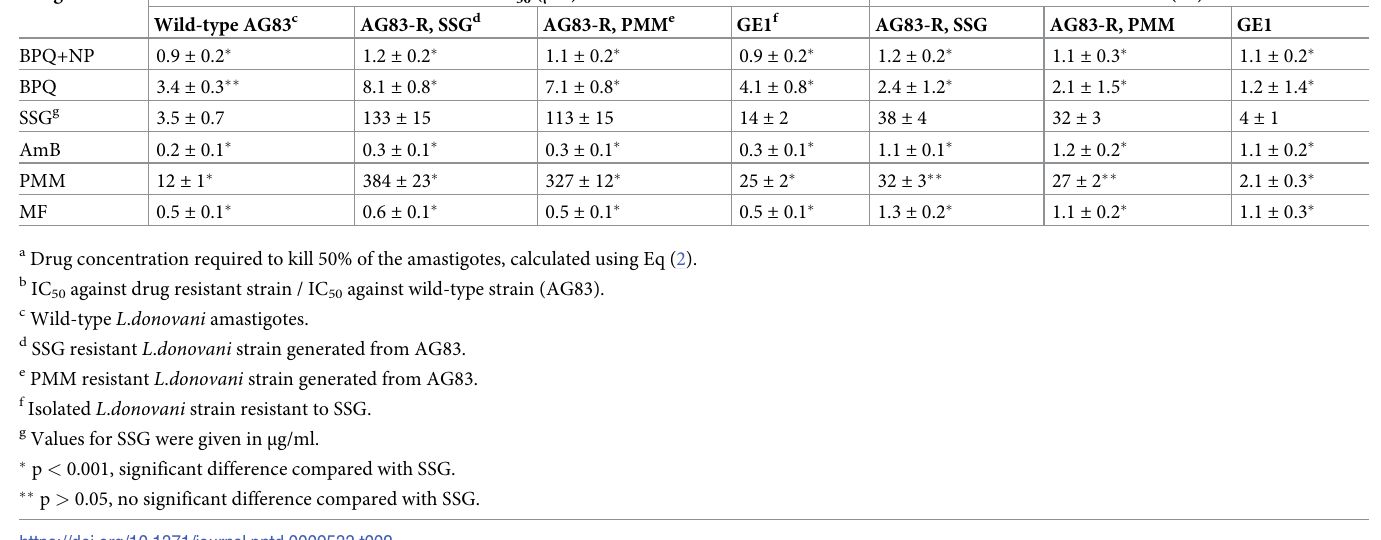
Table 2. Drug sensitivity profiles against axenic L .donovani amastigotes (mean ± σ , n = 4).